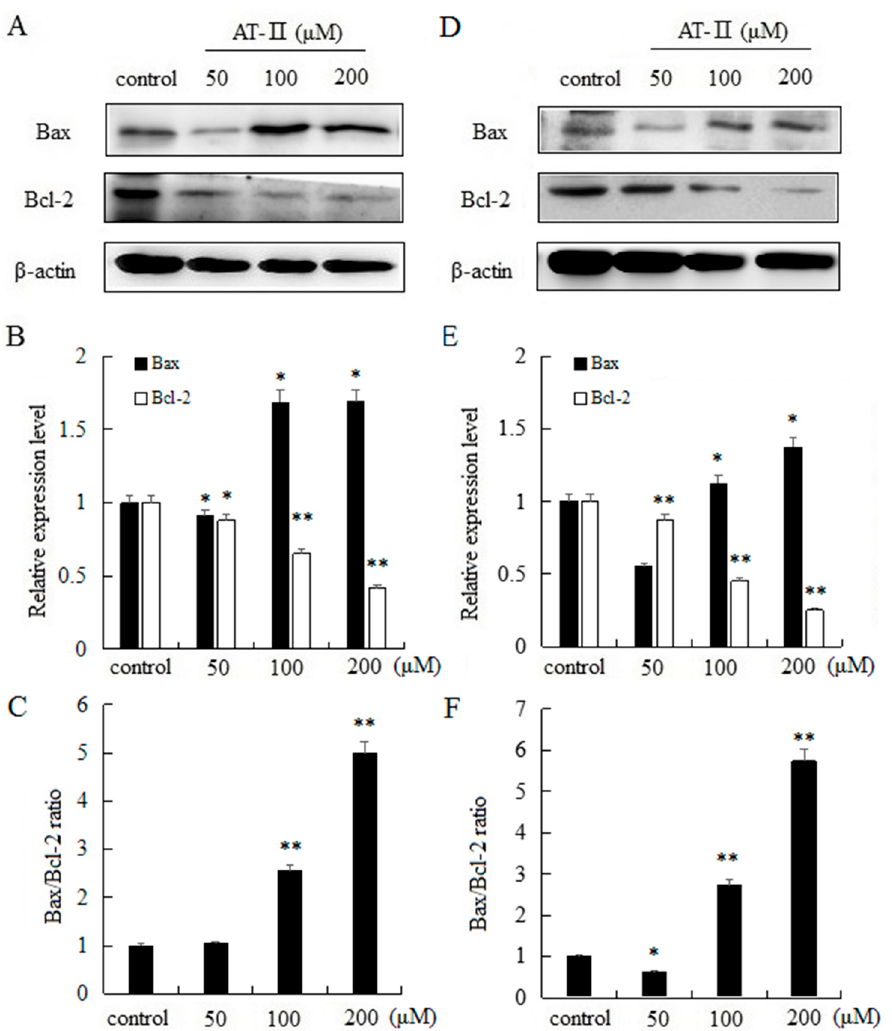
Figure 5. Expression levels of Bax and Bcl-2 and Bax/Bcl-2 ratio in HGC-27 and AGS cells. ( A ) HGC-27 cells; ( B ) relative expression levels of Bax and Bcl-2 in HGC-27 cells; ( C ) Bax/Bcl-2 ratio in HGC-27 cells; ( D ) AGS cells; ( E ) relative expression levels of Bax and Bcl-2 in AGS cells; ( F ) Bax/Bcl-2 ratio in AGS cells. * p < 0.05 and ** p < 0.01 vs. control group.